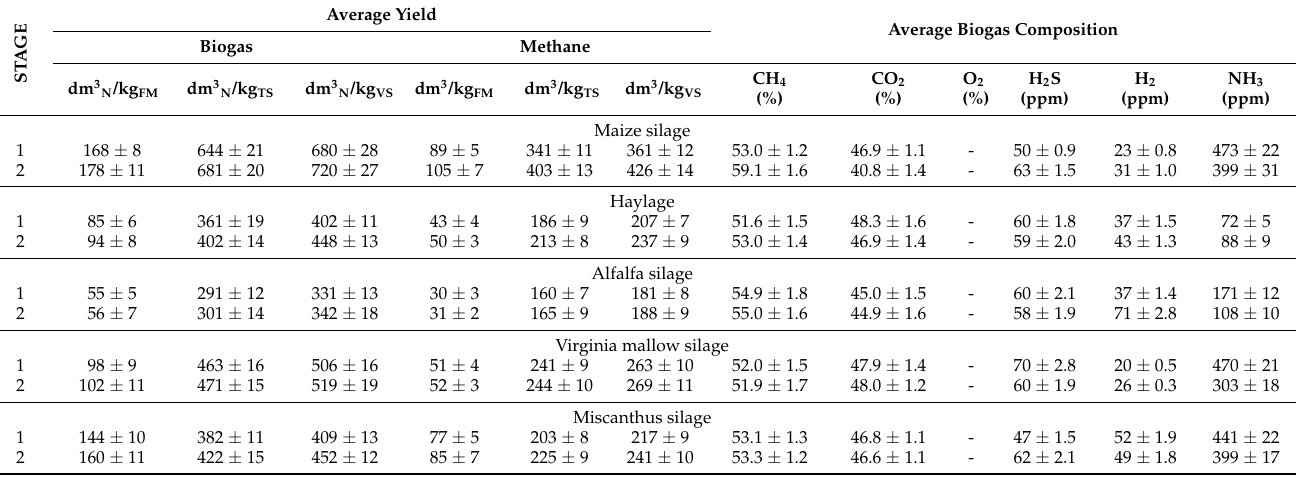
Table 4. Efficiency of biogas and methane production and biogas composition from methane fermen- tation of different energy crops.